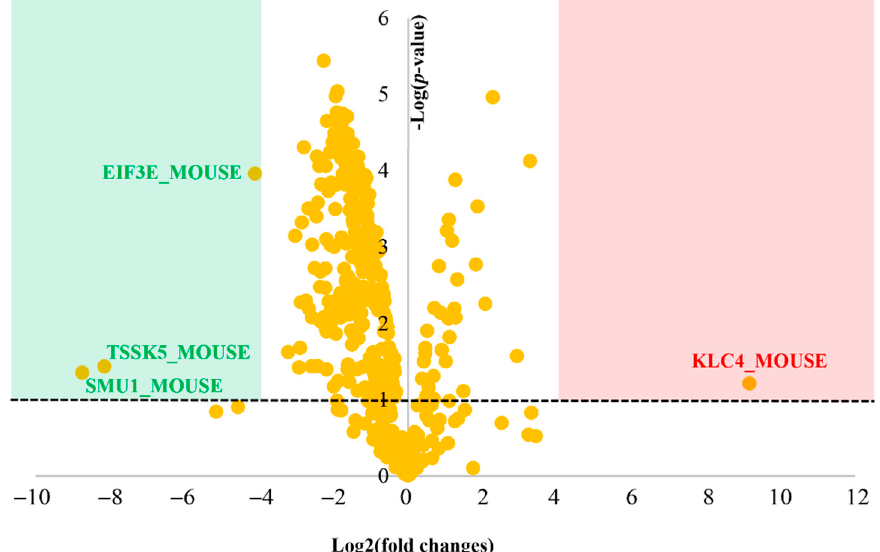
Figure 4. Quantitative proteomic analysis visualized by a volcano plot. The plot shows a negative natural log of the p -values plotted against the base2 logs of the change in each protein compared between the loaded liposome and control groups. Statistically significant results ( p < 0.05) are plotted above the dashed line in the green and red regions. Proteins significantly up- and down-regulated upon the loaded liposome treatment are shown as red and green dots, respectively.